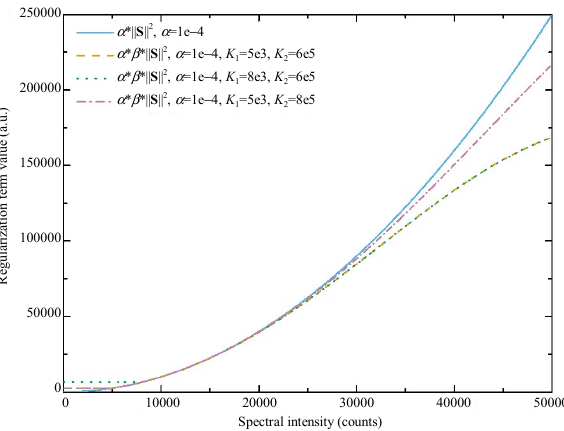
Fig. 1 Differences between the two regularization